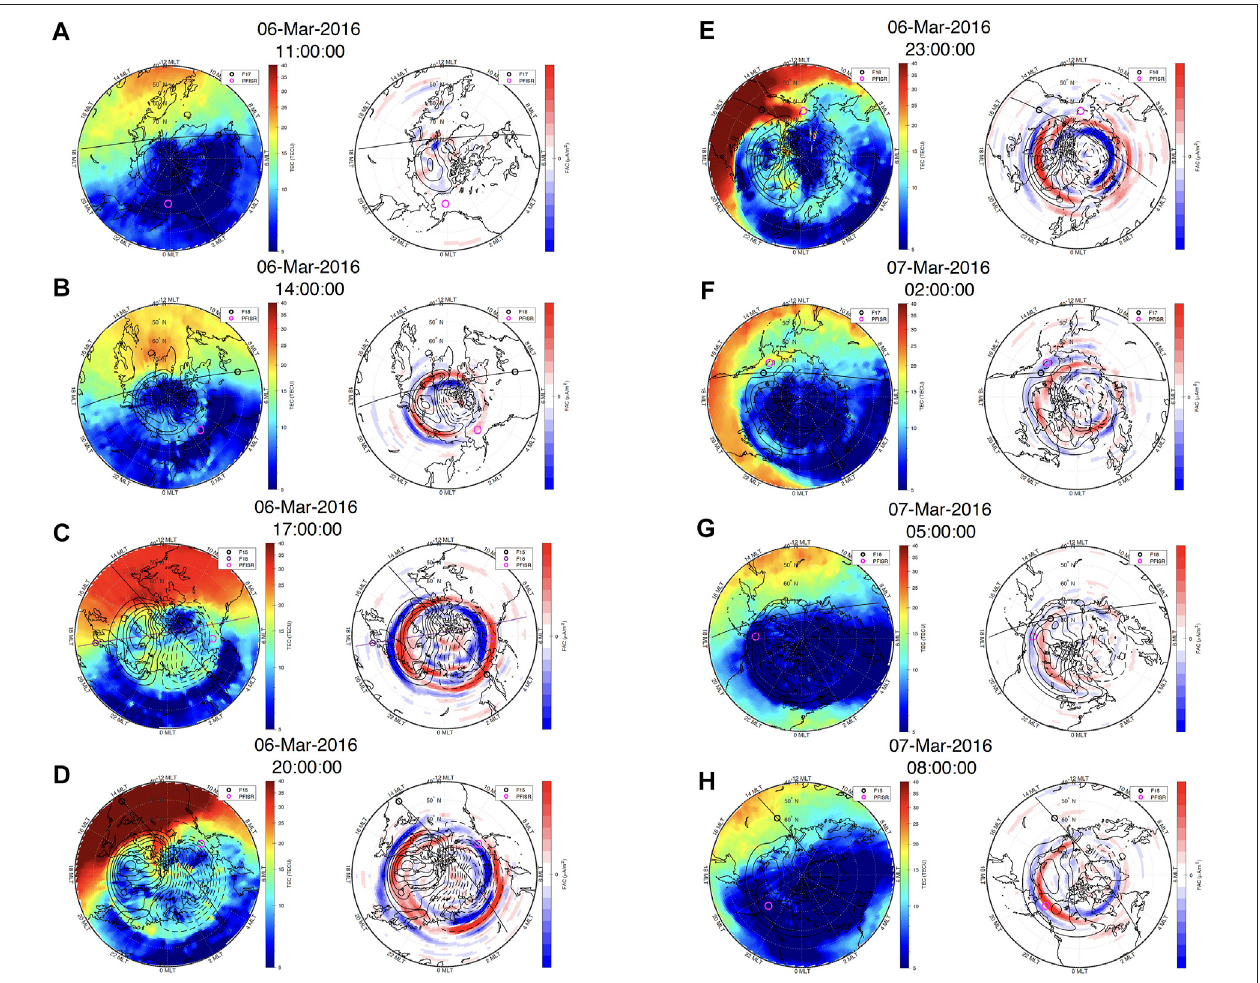
FIGURE2| PolarviewofthenorthernhemisphereTEC,SuperDARNconvection,andAMPEREFACsintheMLTandmagneticlatitudecoordinatesatacadenceof every 3 h starting at 11 UT on March 06. The low latitude boundary in each panel is40 ° mlat. In addition, trajectories ofthe DMSP satellites and their locations (circles) at the time of the plot are shown. Upward FACs are positive and in red colors, while downward FACs are negative and in blue colors.